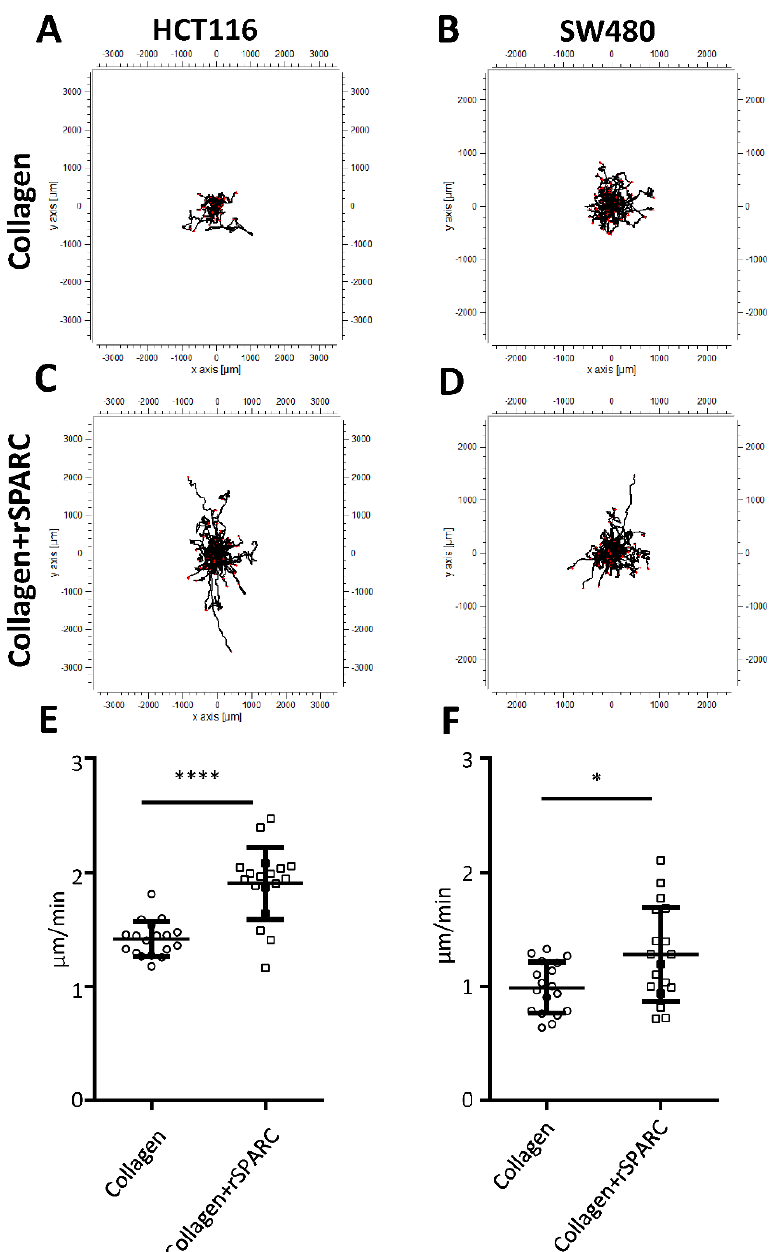
Figure 3. Influence of rSPARC on cancer cell migration. Cancer cells were seeded on collagen I coated plates supplemented with either PBS or PBS + rSPARC and tracked for a total of 22 h. Tracks were transformed to have the same starting points, and HCT116 as well as SW480 cells migrating on either collagen ( A , B ) or collagen + rSPARC ( C , D ) were plotted. Average migration speed in µ m / min are shown for each well (n = 18) for a total of 3 independent experiments for HCT116 ( E ) and SW480 ( F ); statistical analyses were performed by using the Mann-Whitney test. *: p < 0.05; ****: p < 0.0001. Scatter dot plots: center line, means; whiskers, SD; rSPARC, human recombinant SPARC; PBS, phosphate bu ff ered